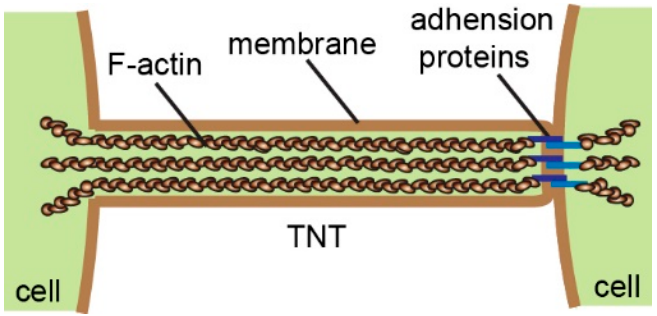
Figure 1. The schematic representation illustrates the structure and general composition of tunneling nanotubes (TNTs).